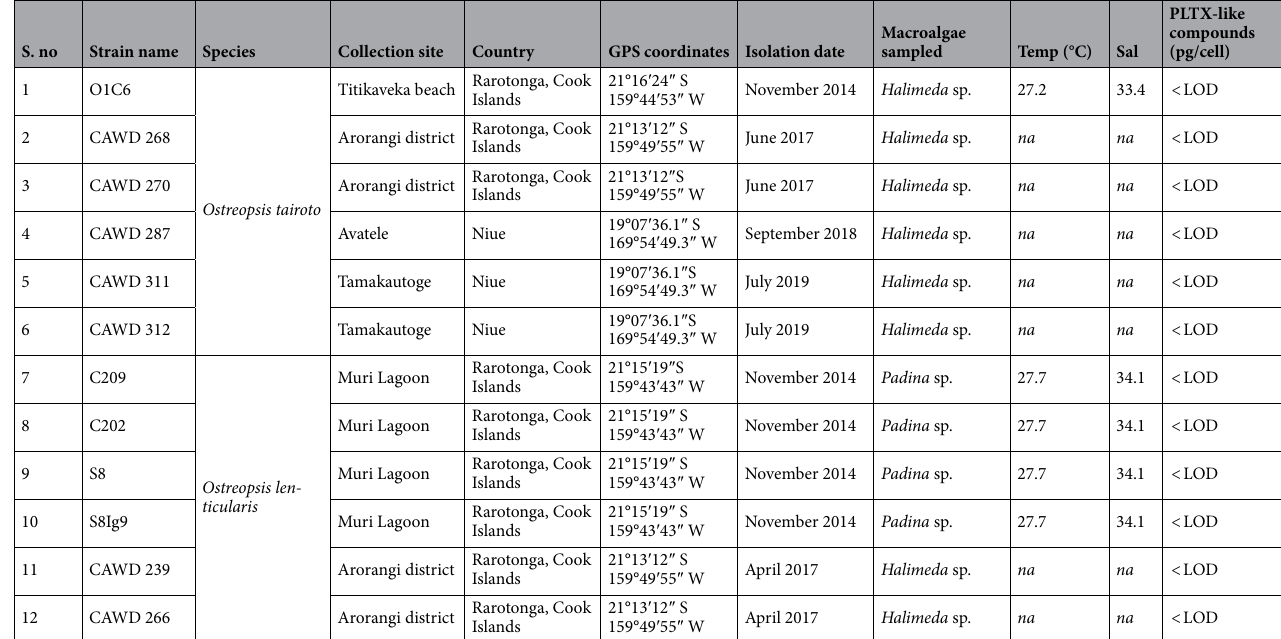
Table 1. Summary of the Ostreopsis strains sampled in this study. na represents no data, LOD represents limit of detection of the LC–MS/MS method used for screening PLTX-like compounds.